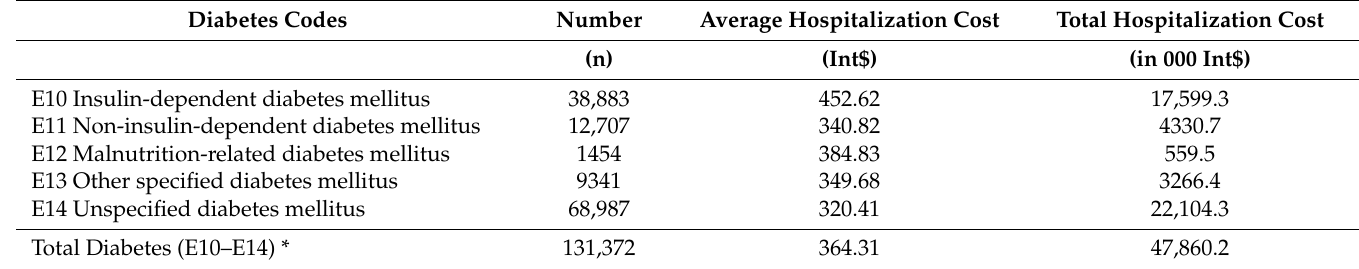
Table 4. Number, average and total hospitalization cost due to diabetes (E10–E14), adults (20+ years), SUS, Brazil, 2014. Diabetes